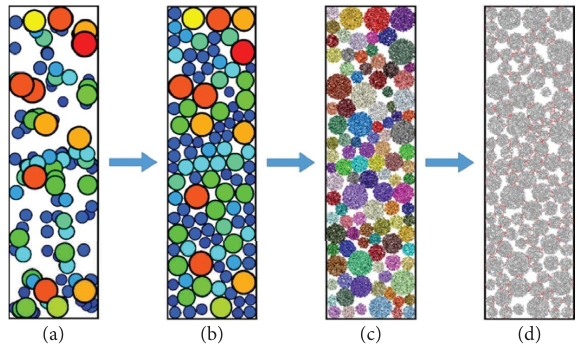
Figure 2: Te basic preparation process of numerical specimens.